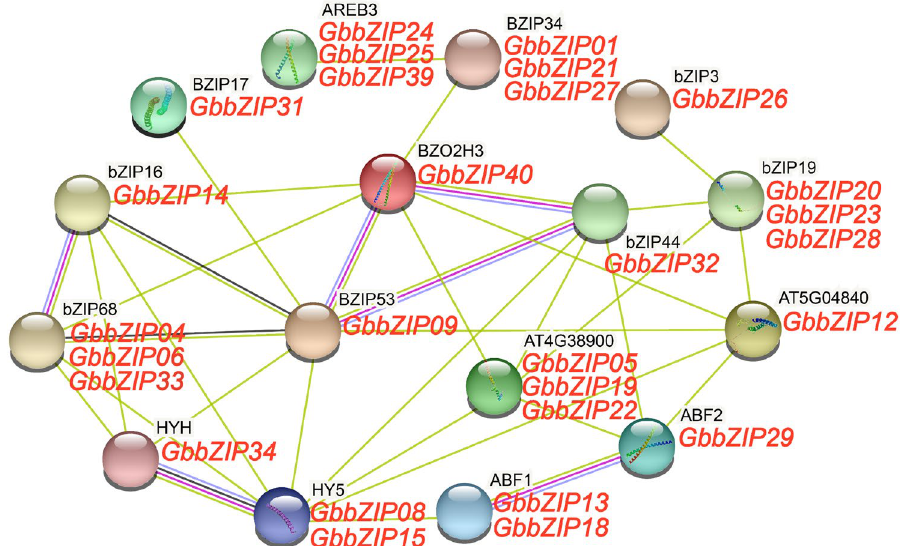
Figure 7. Protein–protein interaction network for GbbZIPs was analyzed by the STRING website (http:// string- db. org/) using the full-length protein sequence 16,36 . Empty nodes indicate proteins of unknown 3D structure. Filled nodes indicate that some 3D structure is known or